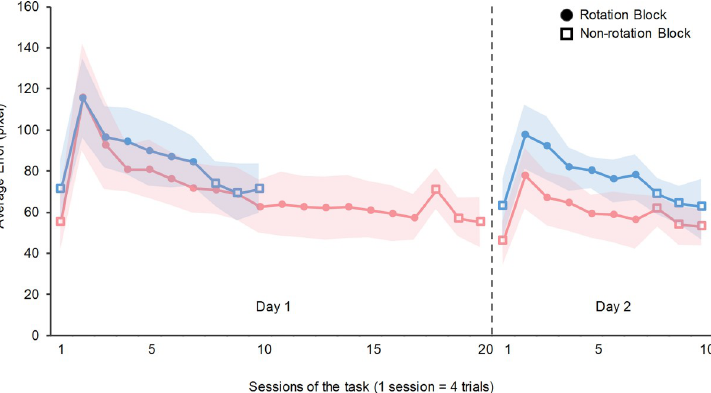
Fig 3. Task performance of Group 1 and Group 2 (24-h-interval groups). The horizontal axis represents the number of sessions of the tracking task, and the vertical axis represents the average error. The dashed line separates the results of Day 1 and Day 2. The blue line represents Group 1 (participants who performed 10 sessions on Day 1). The pink line represents Group 2 (participants who performed 20 sessions on Day 1). The open squares represent non-rotation sessions, and the filled circles represent rotation sessions. The background shadow shows the standard deviation of each group. The error increased in the second session on Day 1 in both the groups, after which it decreased.